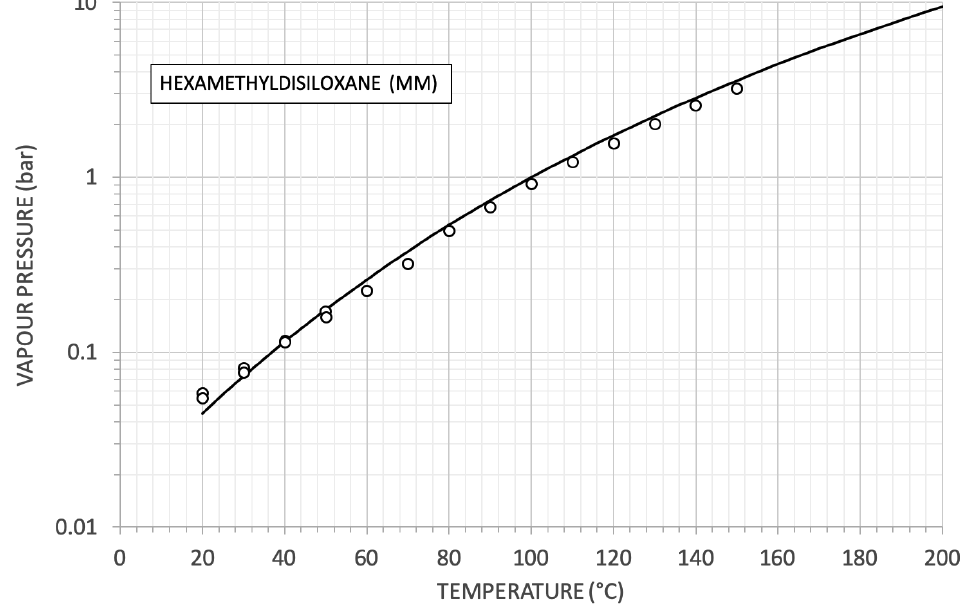
Figure 2. Vapour pressure of hexamethyldisiloxane (MM) as a function of temperature. The continu- ous line is from Aspen Plus © v.9.0; the open circles are from our measured